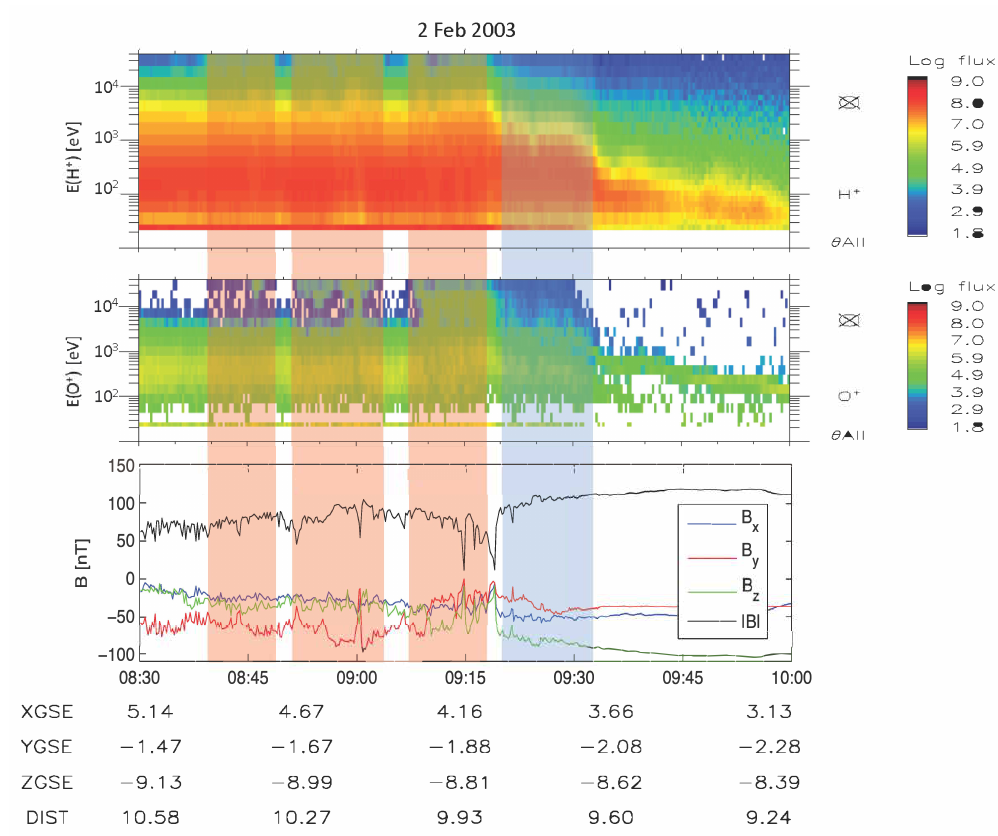
Figure 2. An example of a magnetopause crossing ( ∼ 09:18UT) in the southern high-latitude dayside hemisphere with Cluster 1, travelling from the magnetosheath into the plasma mantle and then the polar cap. The first and second panels show the H + and O + energy spec- trograms respectively. The third panel shows the magnetic field strength and its components. The time intervals of the plasma mantle and magnetosheath data included in this study (for this particular time interval) are marked with blue and red rectangles